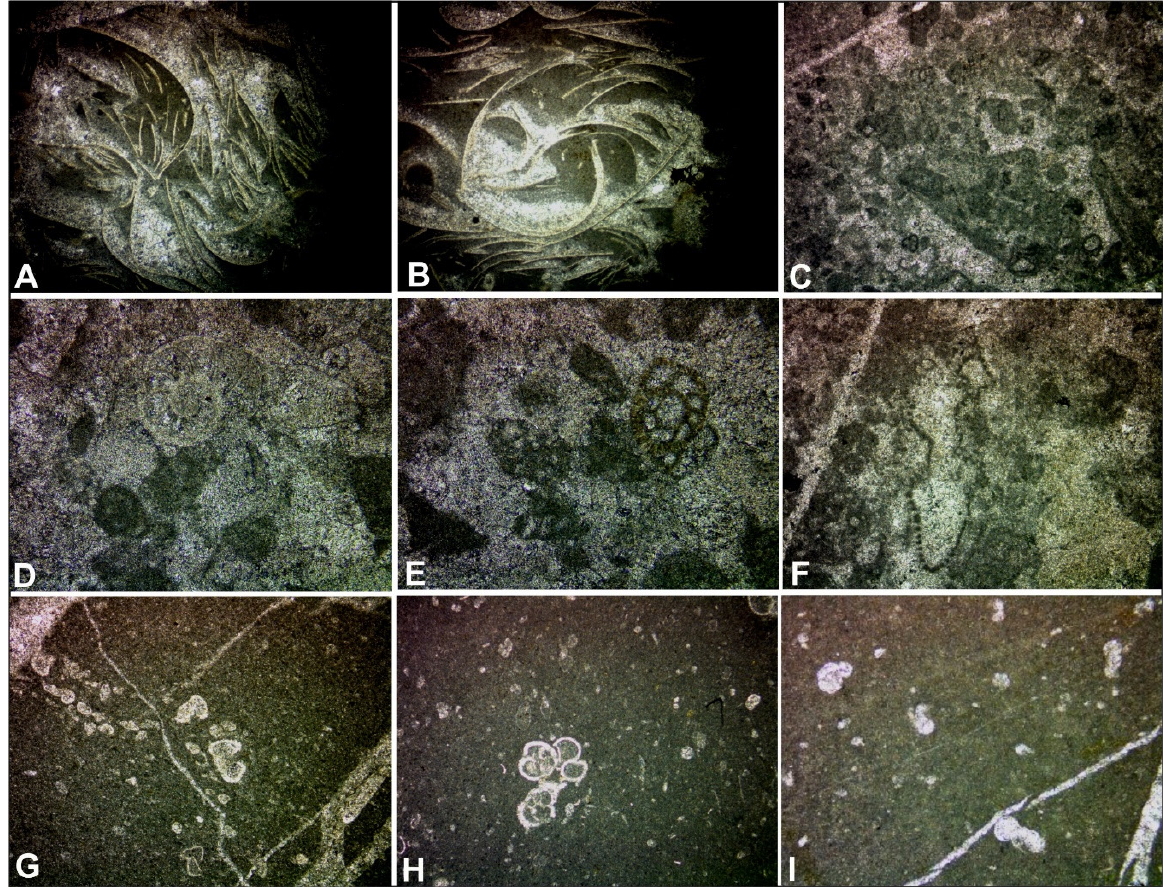
Figure 5. ( A ) KI27 sample of Lower Cretaceous (Valanginian): thin shelled bivalves (filaments) ( X 20), ( B ) KI27 sample of Lower Cretaceous (Valanginian): thin shelled bivalves (filaments) ( X 20), ( C ) KI14 sample of Lower Jurassic: small benthic foraminifera ( X 20), ( D ) KI66 sample of Lower Cretaceous (Albian): grainstone with small benthic foraminifera ( X 100), ( E ) KI66 sample of Lower Cretaceous (Albian): grainstone with small benthic foraminifera ( X 100), ( F ) KI12 sample of Lower Jurassic: Thaumatoporella sp. ( X 40), ( G ) KI83 sample of Paleocene (Selandian-Thanetian): mudstone with Morozovella angulata ( X 40), ( H ) KI92 sample of Eocene (Bartonian-Priabonian): wackestone with Globirerinatheca sp. ( X 40), ( I ) KI72 sample of Upper Cretaceous (Cenomanian): wackestone with Hedbergella delrioensis ( X 100).